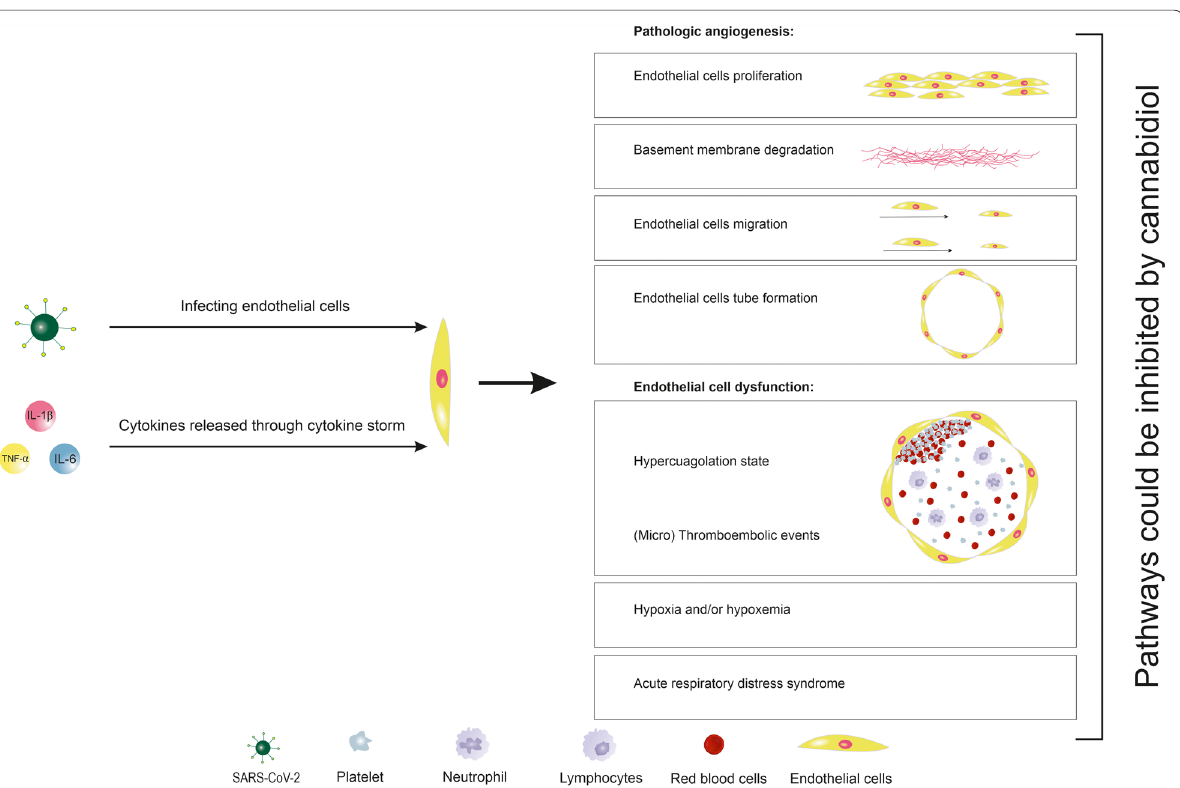
Fig. 1 Short review on the potential of cannabidiol on pathologic angiogenesis and endothelialitis. Severe acute respiratory syndrome coronavirus 2 (SARS-CoV-2) infects the endothelial cells and led to pathologic angiogenesis and endothelial dysfunction. These features could be inhibited by using cannabidiol treatment. IL, interleukin; TNF-α, tumor necrosis factor